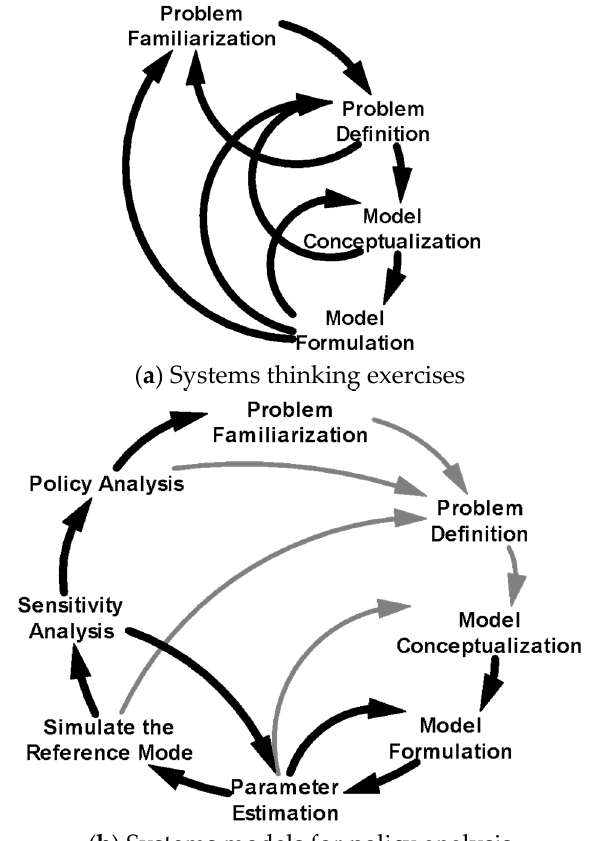
Figure 1. The eight steps of model building: ( a ) Iterative system thinking exercises for identifying and clarifying problems; ( b ) building simulation models expands the iterative process to include sensitivity analysis and policy analysis. Source: Beall and Ford [25].